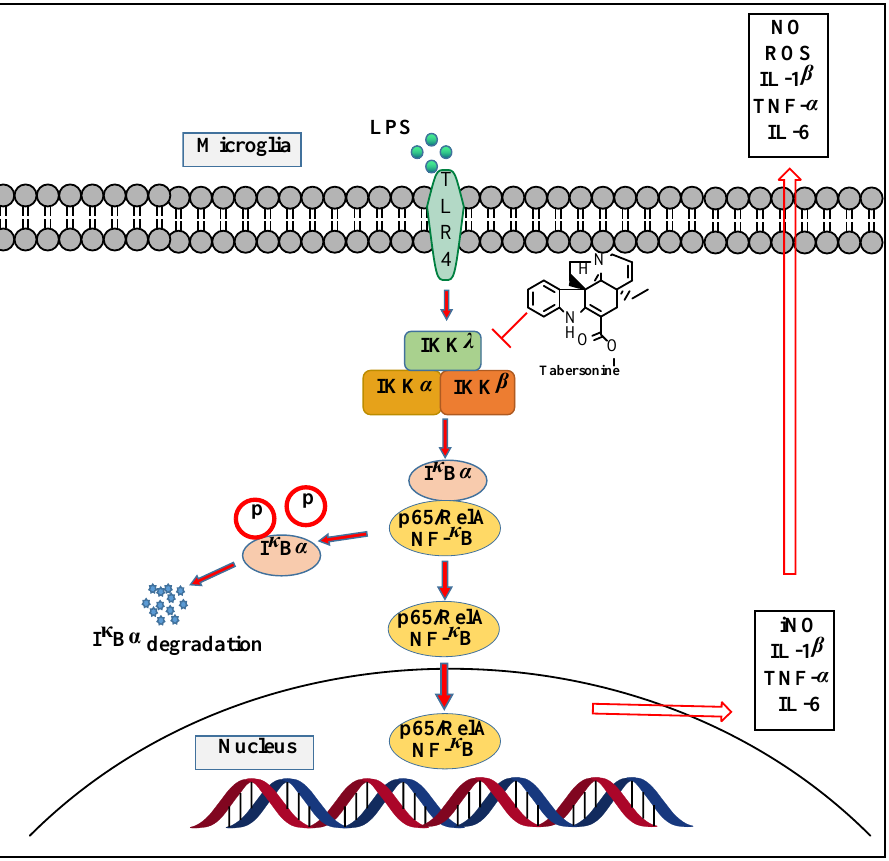
Figure 6. A schematic diagram for the potential molecular mechanism of the anti-neuroinflammatory effect of Tab through the NF- κ B pathway.